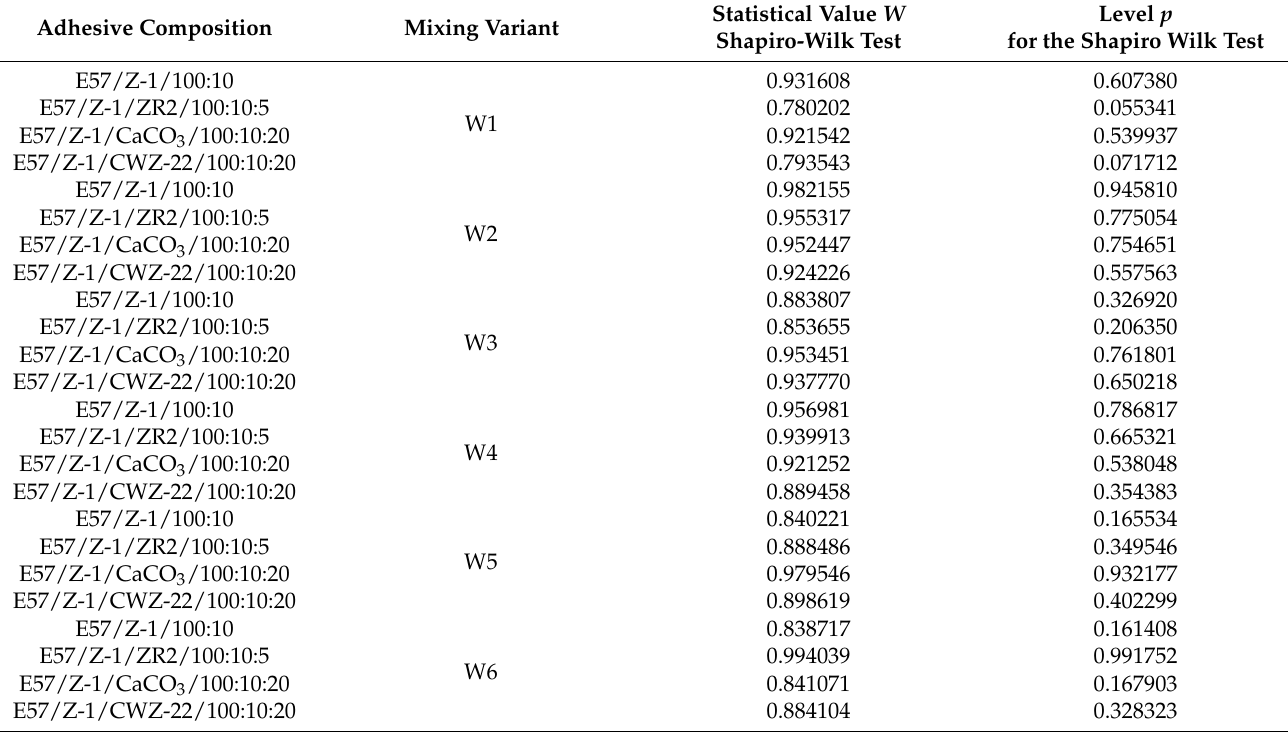
Table A1. Results of the Shapiro–Wilk tensile strength test of adhesive